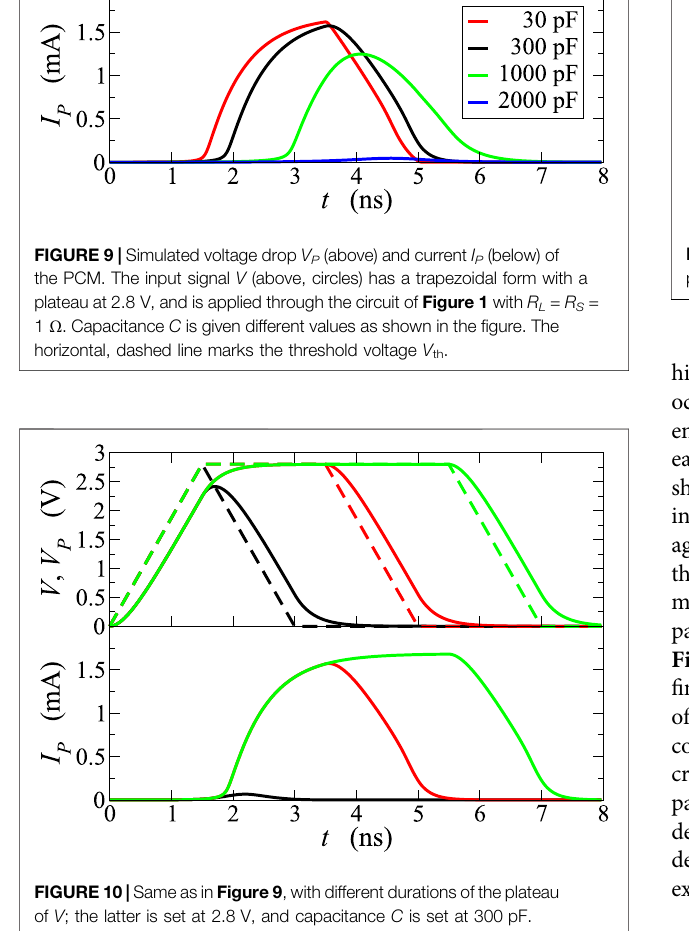
Frontiers in Physics |